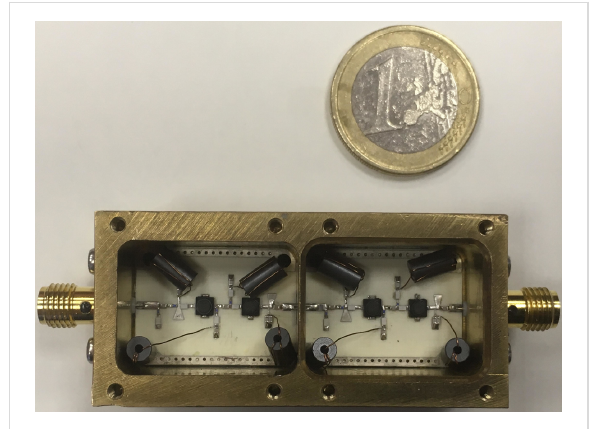
Figure 2: Realization of the cryogenic LNA.